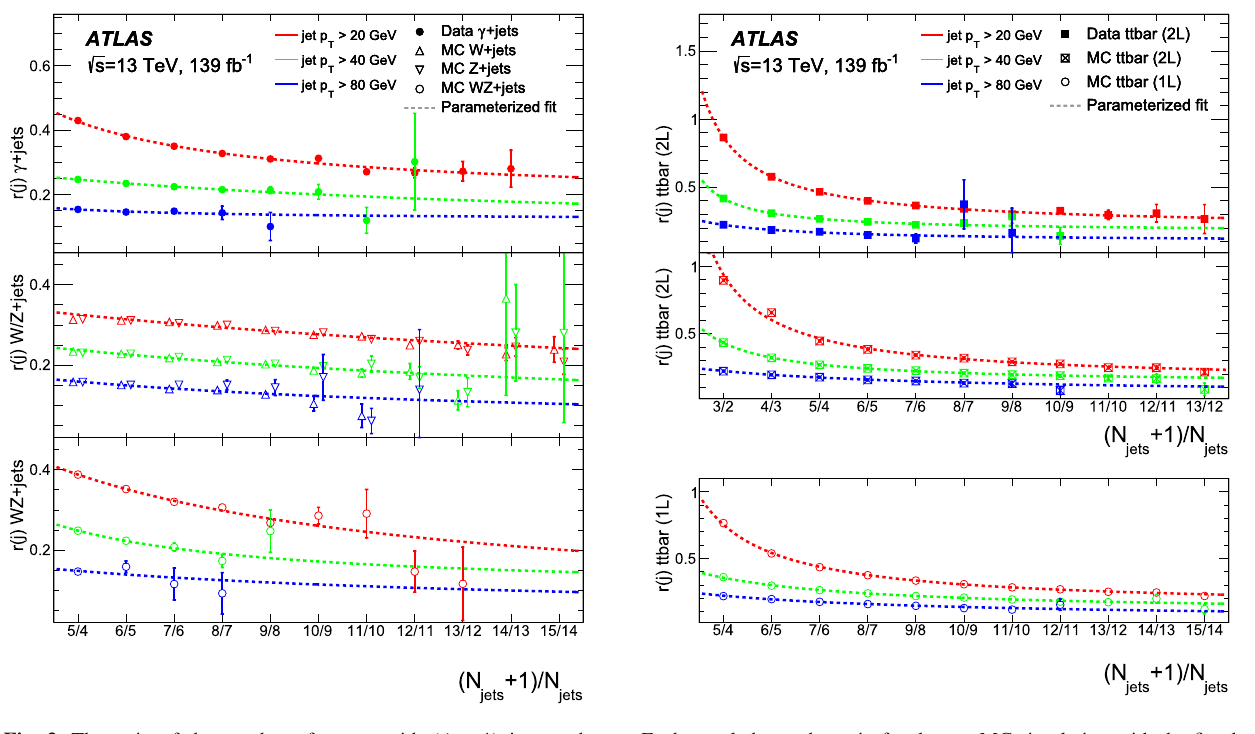
Each panel shows the ratio for data or MC simulation with the fitted parameterization overlaid as a dashed line. The uncertainties shown are